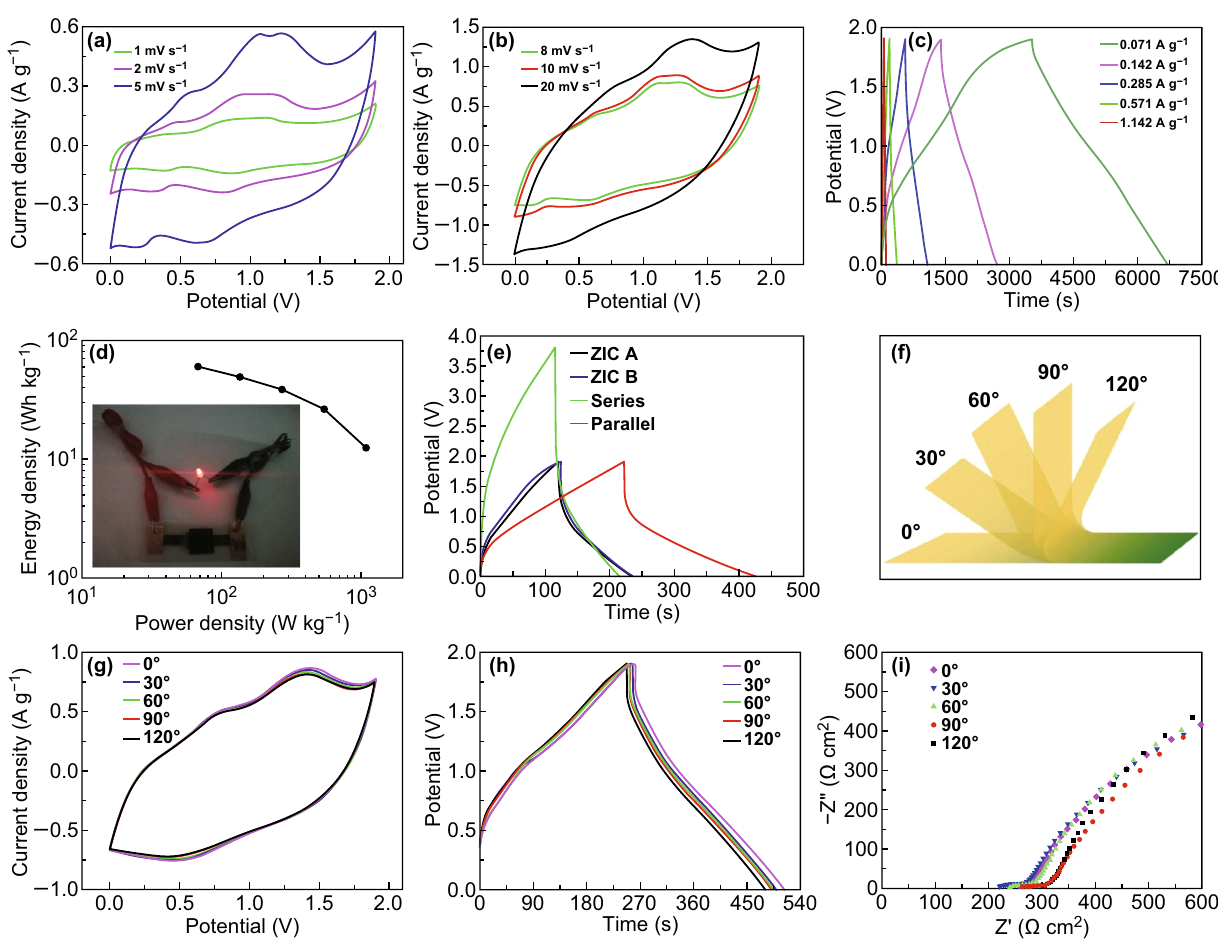
Fig. 5 Electrochemical performance and flexibility of the ZIC in the aqueous gel electrolyte. a , b CV curves, c GCD curves, and d energy and power density plot (inset shows a LED drove brightly by a single ZIC) of the ZIC. e GCD curves of a single ZIC (A, B) and ZICs connected in series and in parallel. f Schematic diagram of the flexible display of the ZIC. g CV curves at a scan rate of 10 mV s −1 , h GCD curves at a current density of 0.415 A g −1 , and i Nyquist plot of the ZIC bent from 0° to